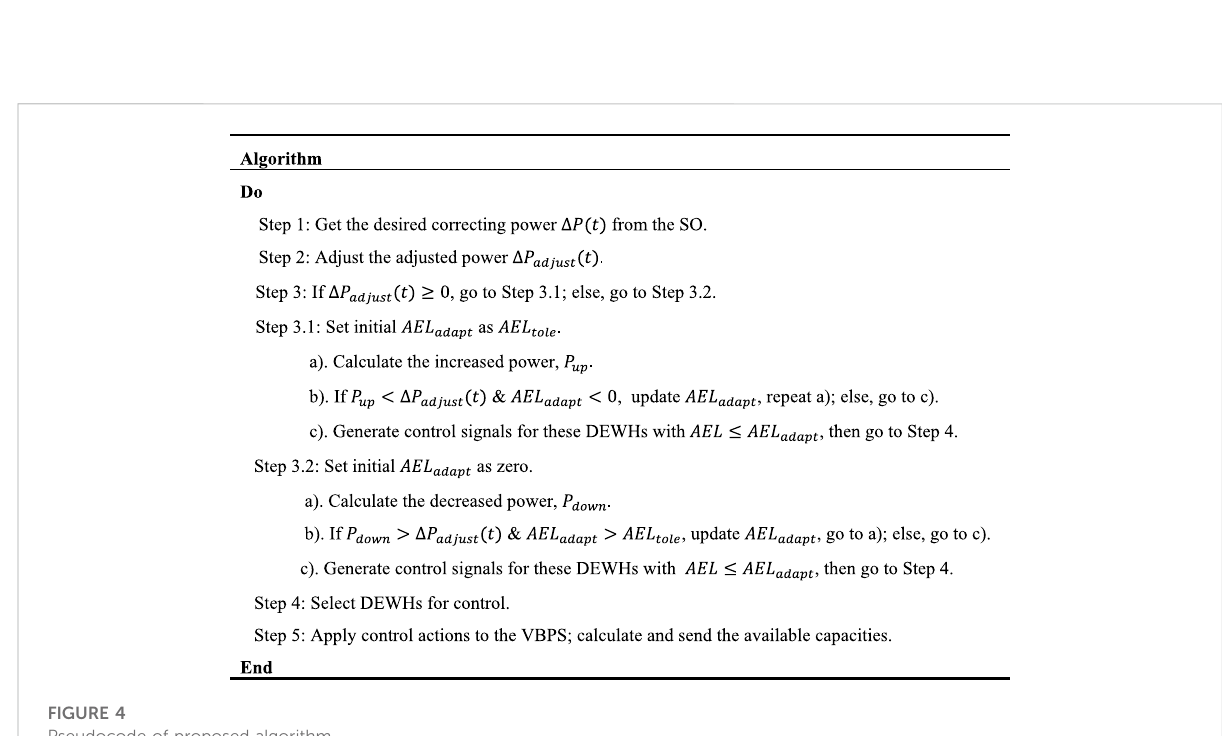
FIGURE 4 Pseudocode of proposed